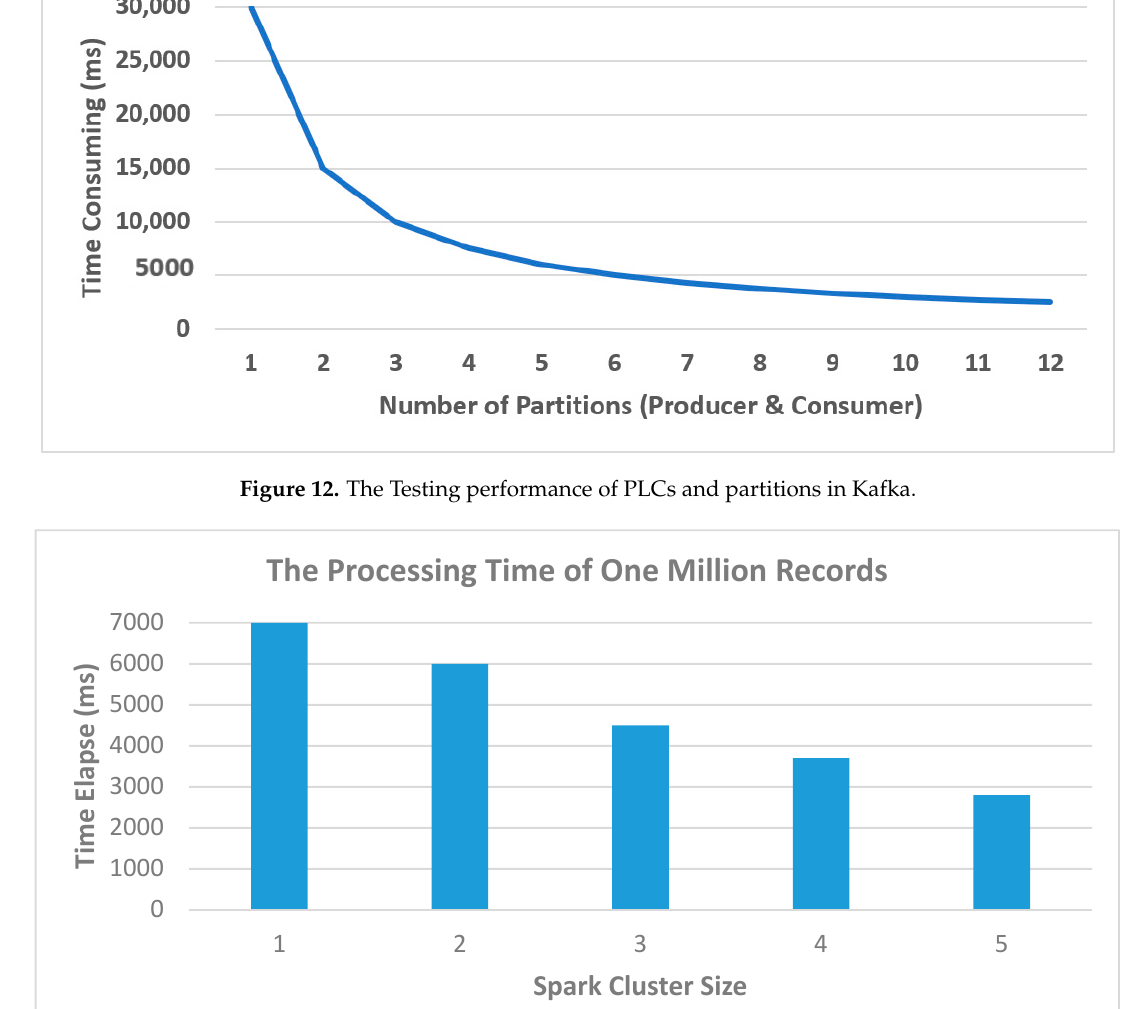
Figure 13. Using Spark Cluster to improve processing time.